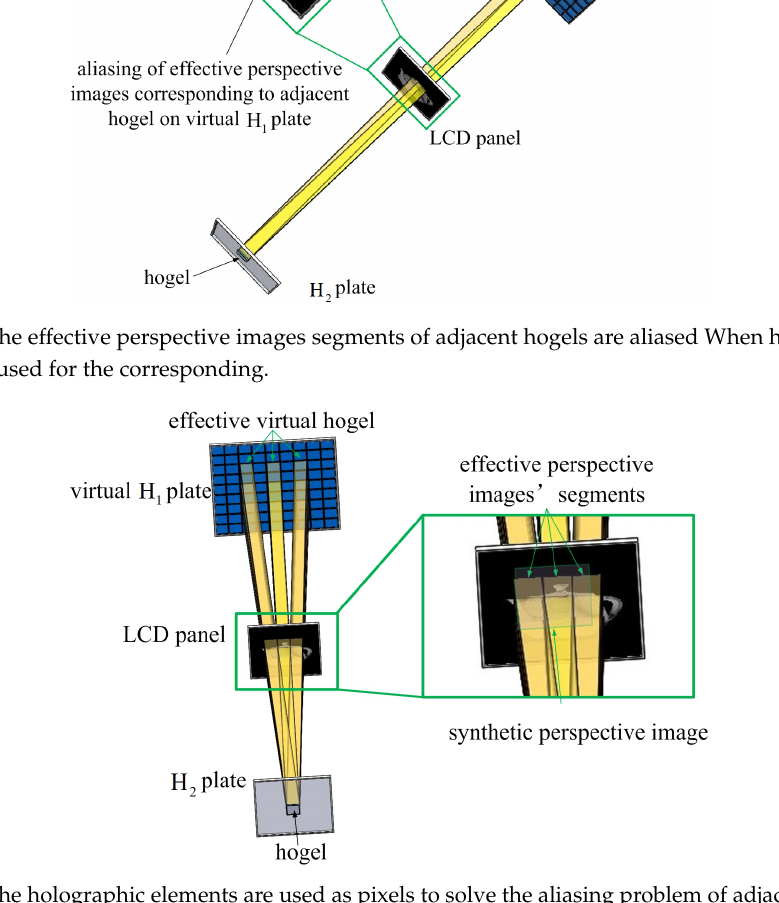
Figure 4. The holographic elements are used as pixels to solve the aliasing problem of adjacent